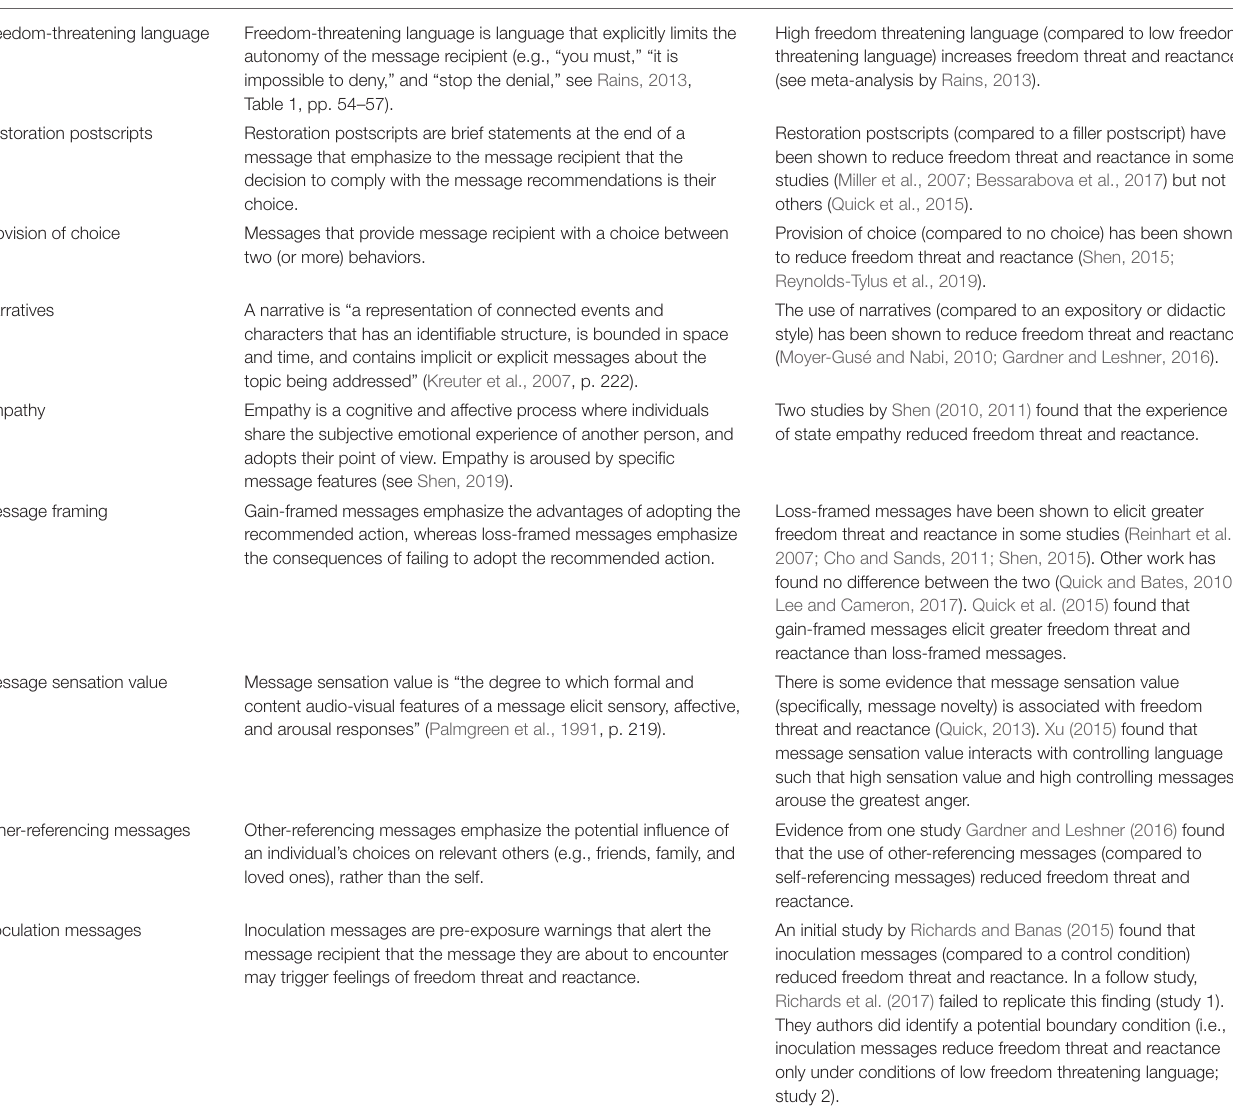
TABLE 1 | Description of message features and their relationship to